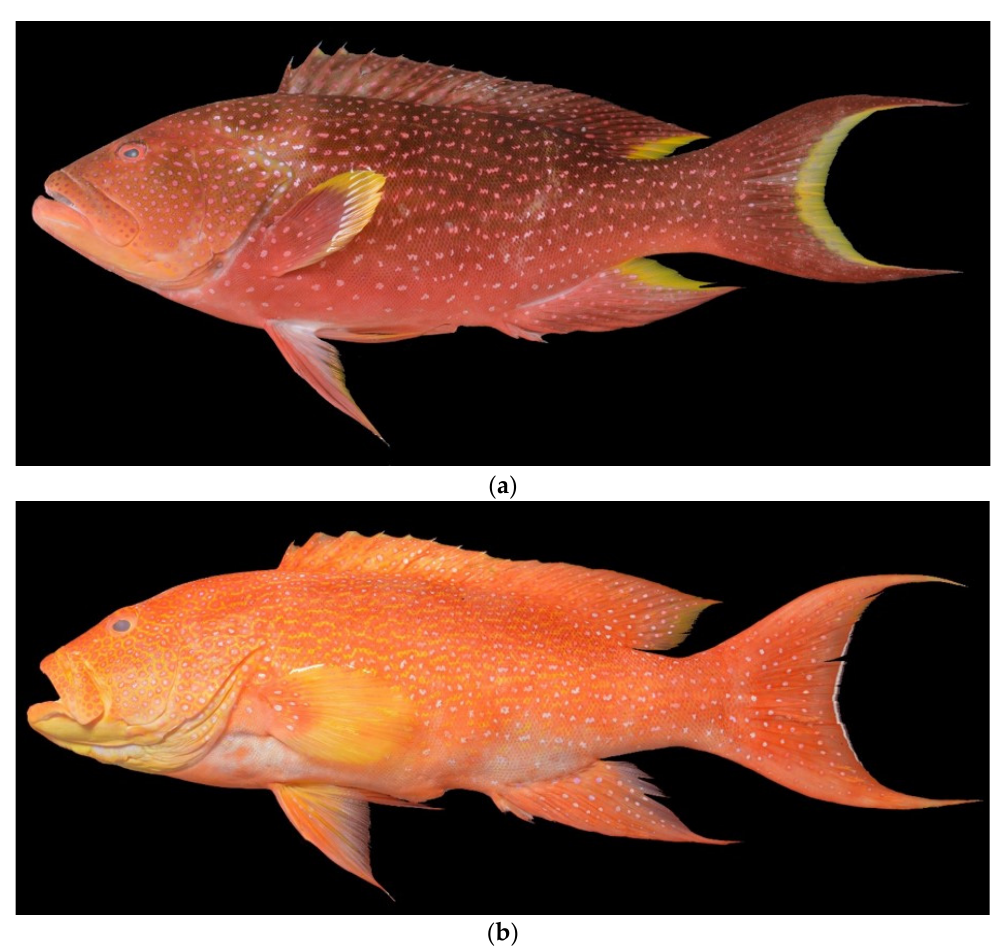
Figure 2. The groupers, Variola louti ( a ) and Variola albimarginata ( b ). Over a period of 22 years, from 1989 to 2011, while V. louti was the primary cause